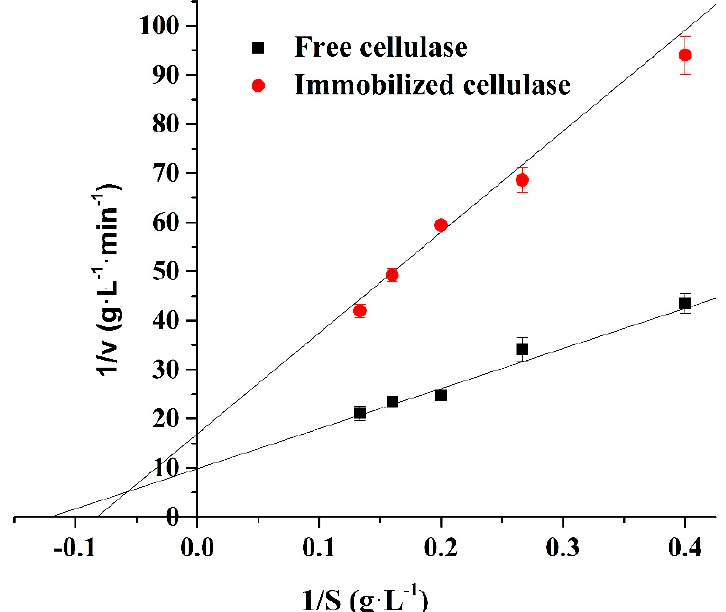
Figure 9. Effect of the CMC concentration on the cellulase activity (the cellulase concentration was 0.01 mg/mL at pH 4 and 60 °C for 5 min). 1/V is the reciprocal of the enzymatic reaction rate and 1/S is the reciprocal of the substrate concentration. Table 2. Kinetic parameters of the free and immobilized